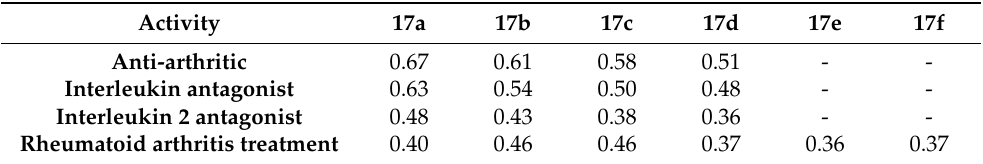
Table 4. The PASS predicted probability of the new pyrrole derivatives to be active (Pa) as anti- arthritic drugs.